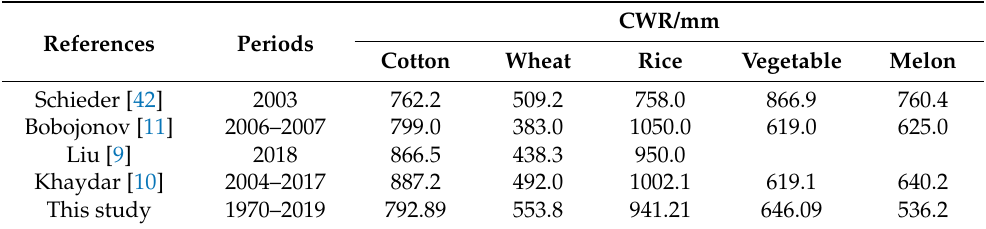
Table 6. Comparison of the average crop water requirement (CWR) values for main crops in the study